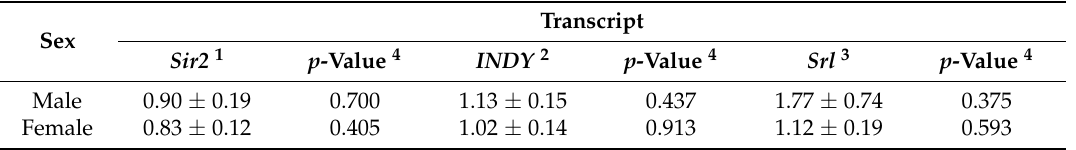
Table 4. Relative mRNA expression of longevity-associated genes in male and female w 1118 D. melanogaster in dependence of resveratrol (RESV; 500 µ mol/L) administration for ten days compared to